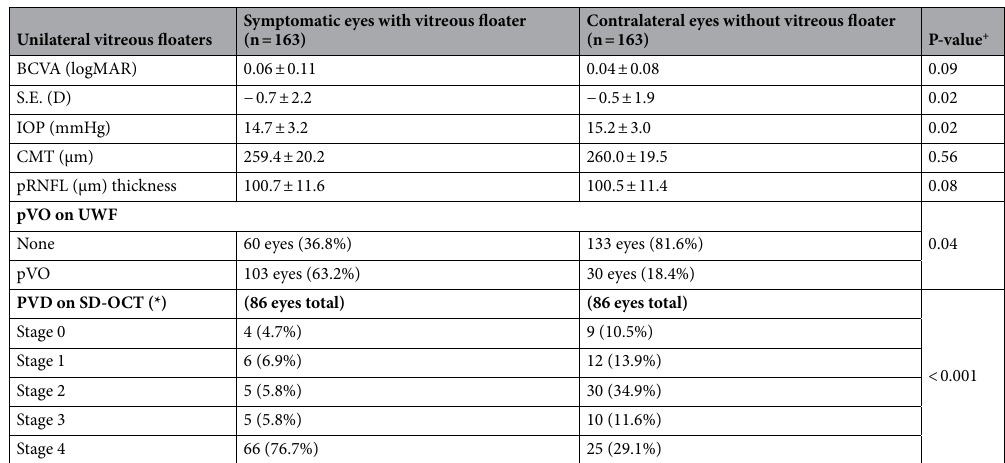
Table 2. Comparison between ophthalmological outcomes of eyes with and without vitreous floaters among patients with unilateral symptomatic eyes. *PVD was staged according to SD-OCT finding as Stage A (perifoveal), Stage B (macular PVD with vitreopapillary adhesion), and Stage C (complete PVD). The SD-OCT data for 53% (86 out of 163 eyes) were available. + P-value was calculated using the Student t test for numerical values and Fisher exact test for categorical values. BCVA best-corrected visual acuity, logMAR the logarithm of the minimal angle of resolution, S.E. spherical equivalents, D diopters, IOP intraocular pressure, CMT central macular thickness, pRNFL peripapillary retinal nerve fiber layer, pVO peripapillary vitreous opacity, UWF ultra-widefield scanning laser ophthalmoscopy, PVD posterior vitreous detachment, SD-OCT spectral domain- optical coherence